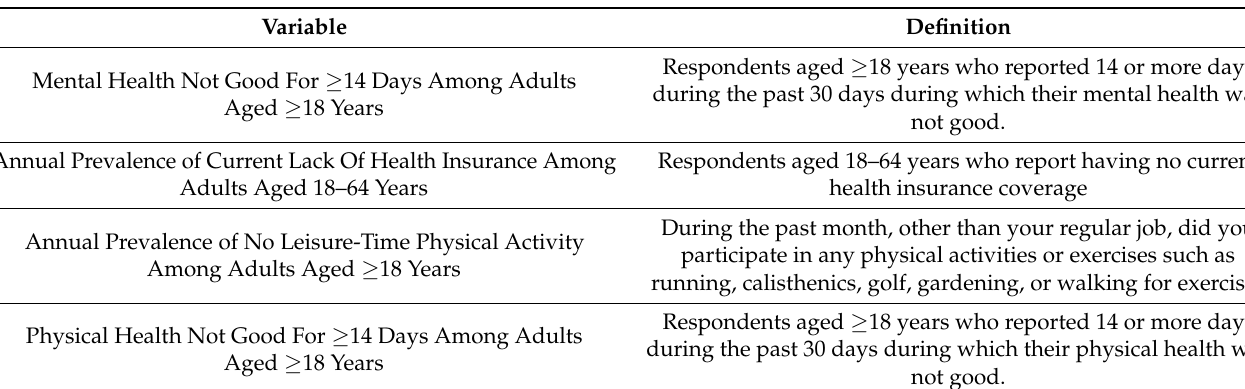
Table 1. PLACES Variable